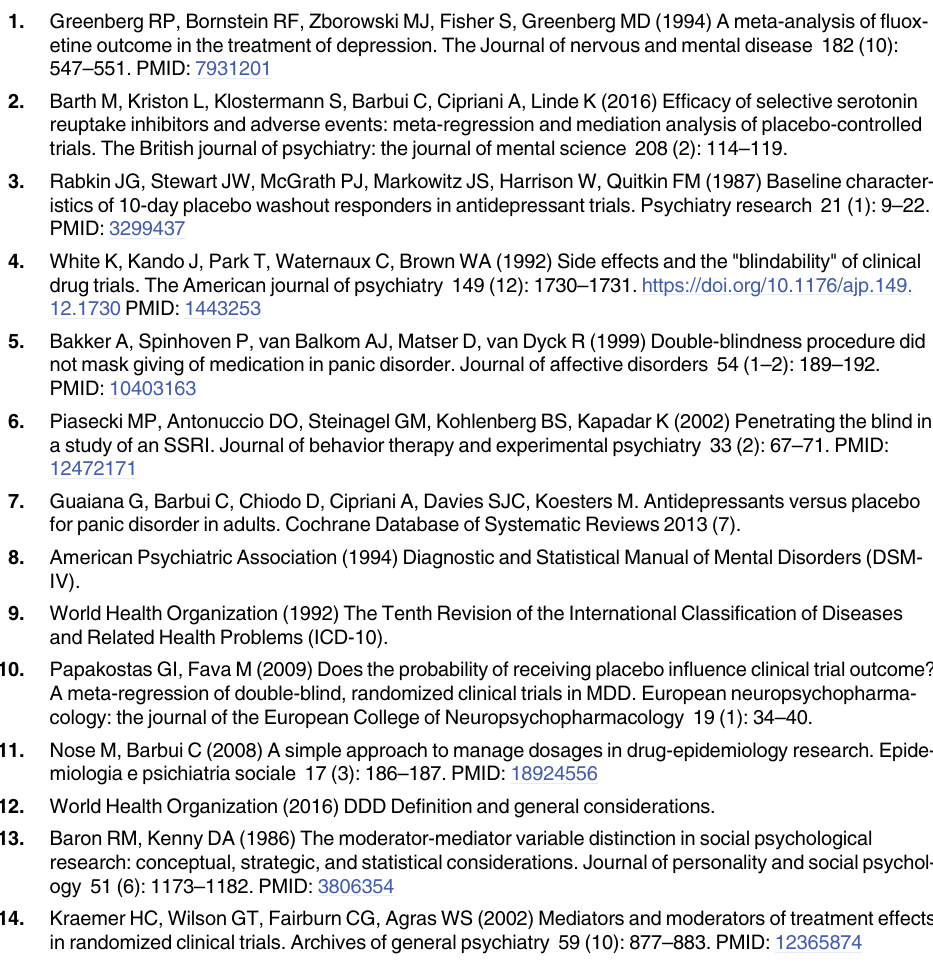
S2 Table. Dataset antidepressants placebo for mediational